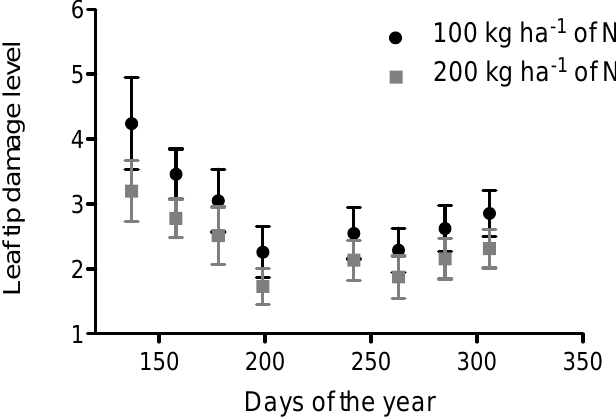
Figure 3. Effects of nitrogen rates on bermudagrass leaf tip damage level (Equation (1)) on June 7, June 27, July 18, August 30, September 20 and October 12. For each assessment date, leaf tip damage level values were statistically different at p < 0.05 when nitrogen rate 100 and 200 kg ha − 1 were applied.